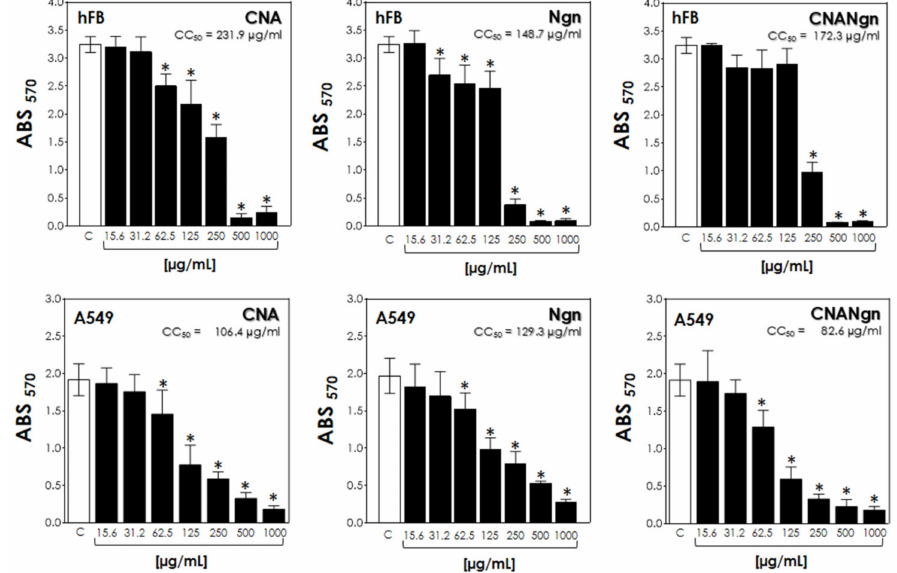
Figure 7. Cell viability of hFB ( top ) cells and A549 ( bottom ) cells treated with CNA (CNT after acid treatment), Ngn (naringenin) and CNANgn (CNA treated with naringenin) tested by MTT assay at a series of concentrations after 48 h. The data represents the mean ± standard deviation of n = 3; * significant di ff erence comparing the di ff erent concentrations ( p <